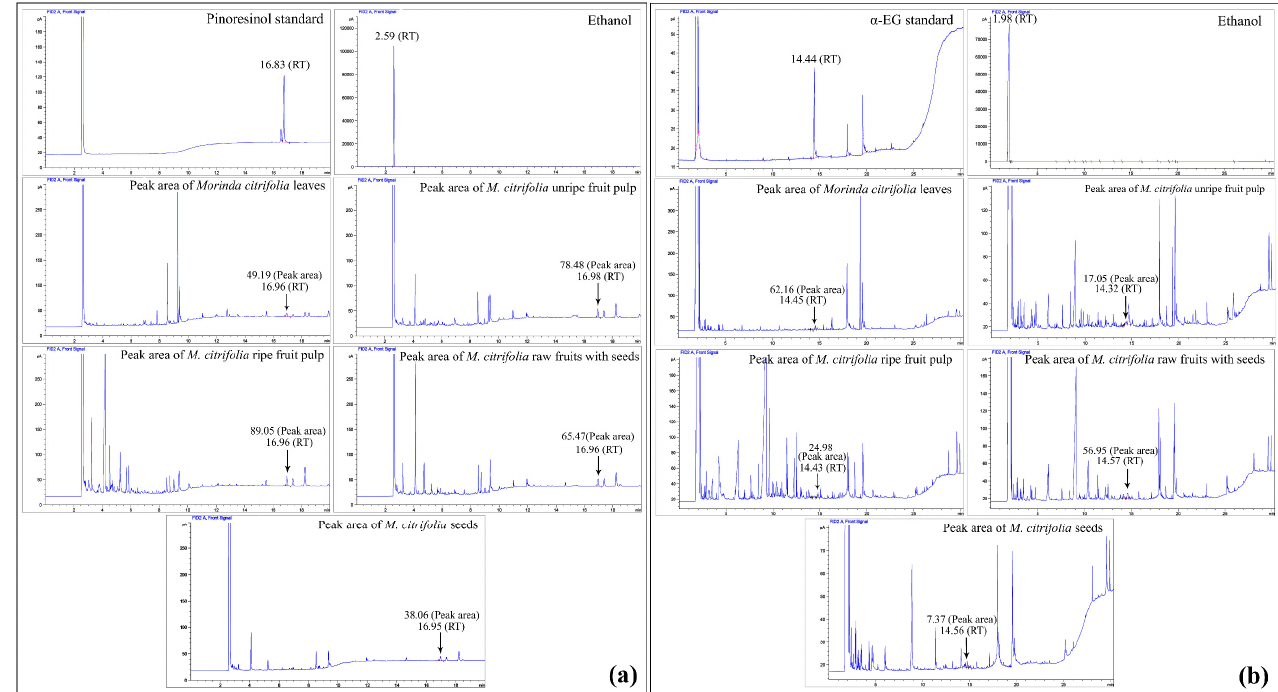
Figure 2. GC chromatograms of the pinoresinol ( a ) and α -EG standards ( b ), ethanol solvent and pinoresinol and α -EG peak areas from Morida citrifolia ( Mc ) plant parts.